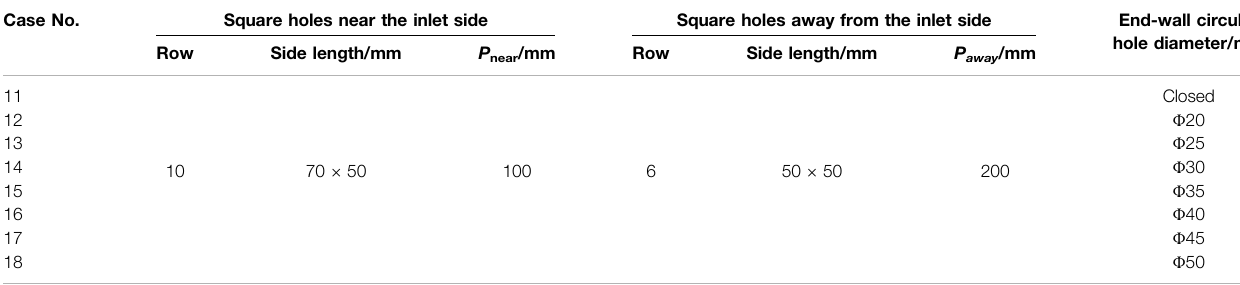
TABLE 5 | Characteristic geometrical parameters of fl ow homogenizers with different end-wall circular hole diameters. Case No. Square holes near the inlet side Square holes away from the inlet side End-wall circular